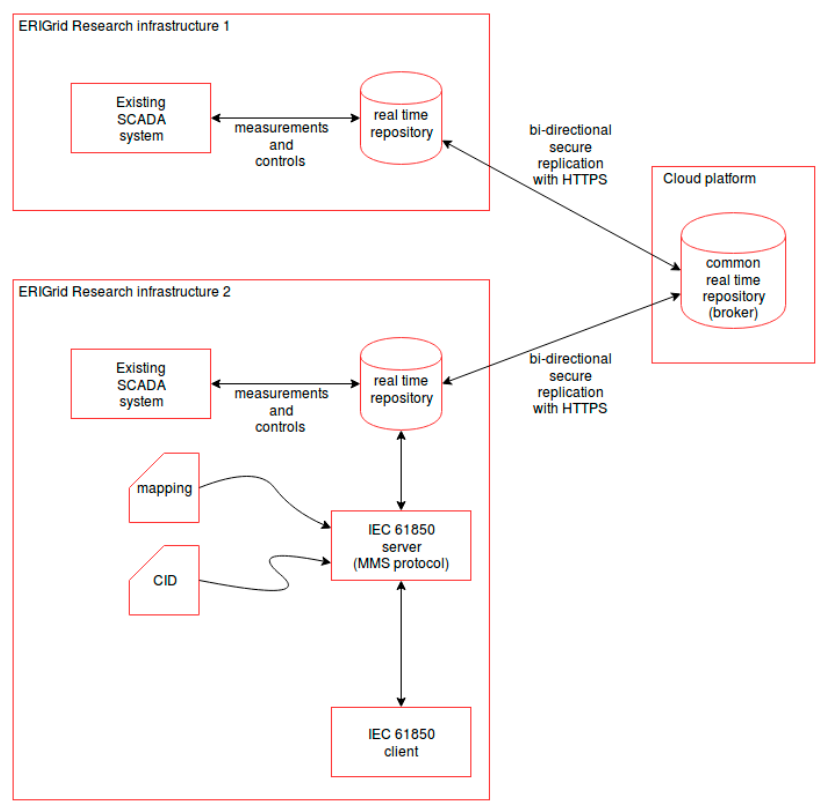
Figure 3. JaNDER Level 1 architecture.